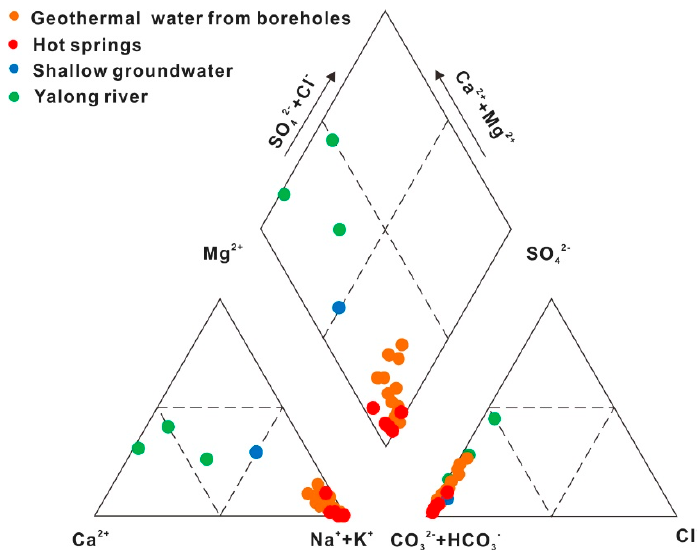
Figure 3. Piper diagram of water samples from the Ganzi geothermal field.